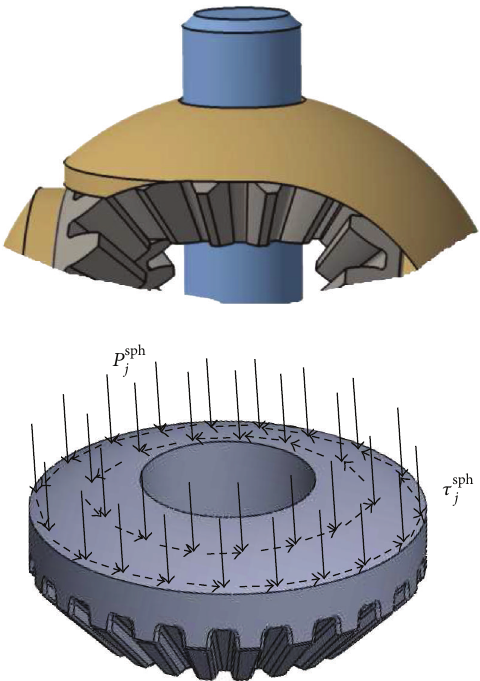
Figure 9: Pressure 𝑃 sph 𝑗 (solid arrow) and shear 𝜏 sph 𝑗 (dashed arrow) fields on a head-pinion 𝑗 (with 𝑗 = ( sa , pl ) ) caused by the plastic